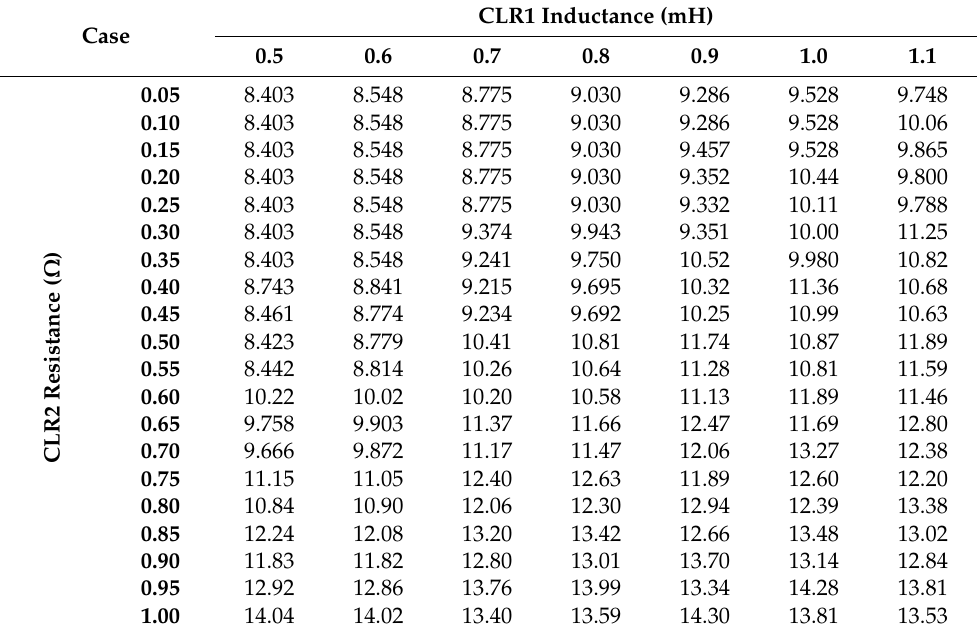
Table 4. Peak of arc current